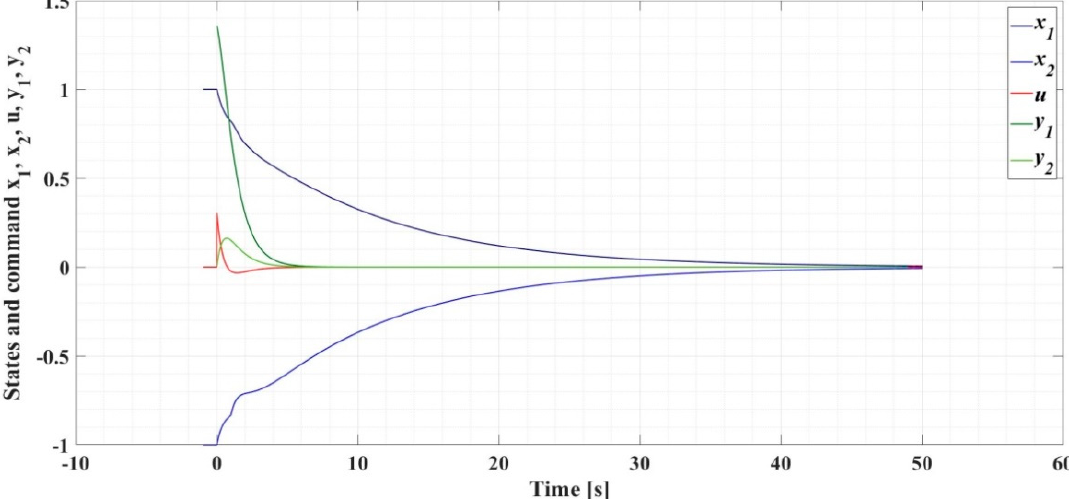
Figure 1. Evolution of the states without input saturation.